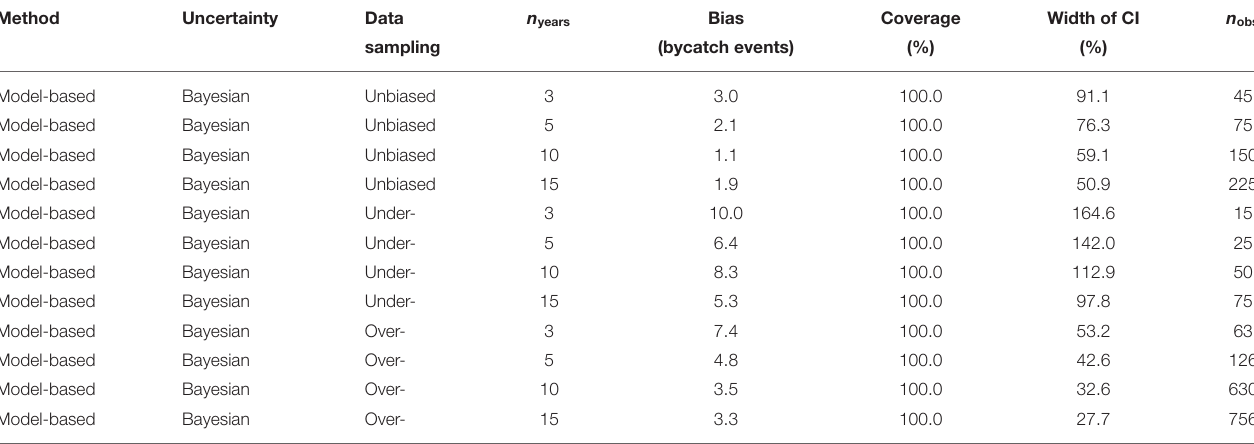
TABLE 2 | Statistical properties of estimates from the model-based